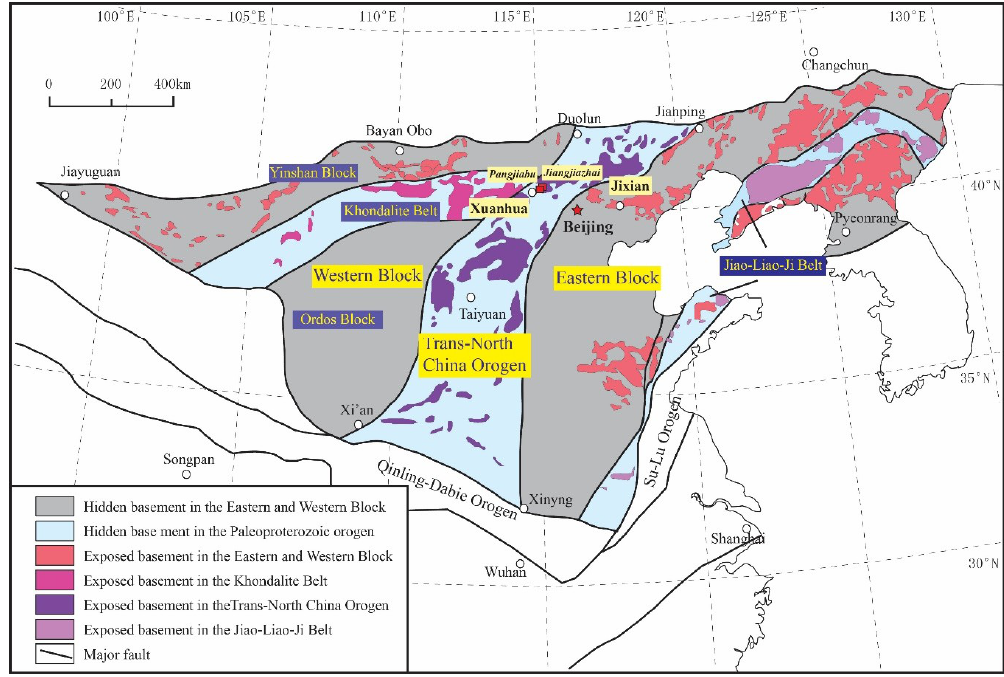
Figure 1. Tectonic subdivision of the North China Craton (modified after Zhao et al., 2012 [7]). Pangjiabu and Jiangjiazhai are the sampling locations.